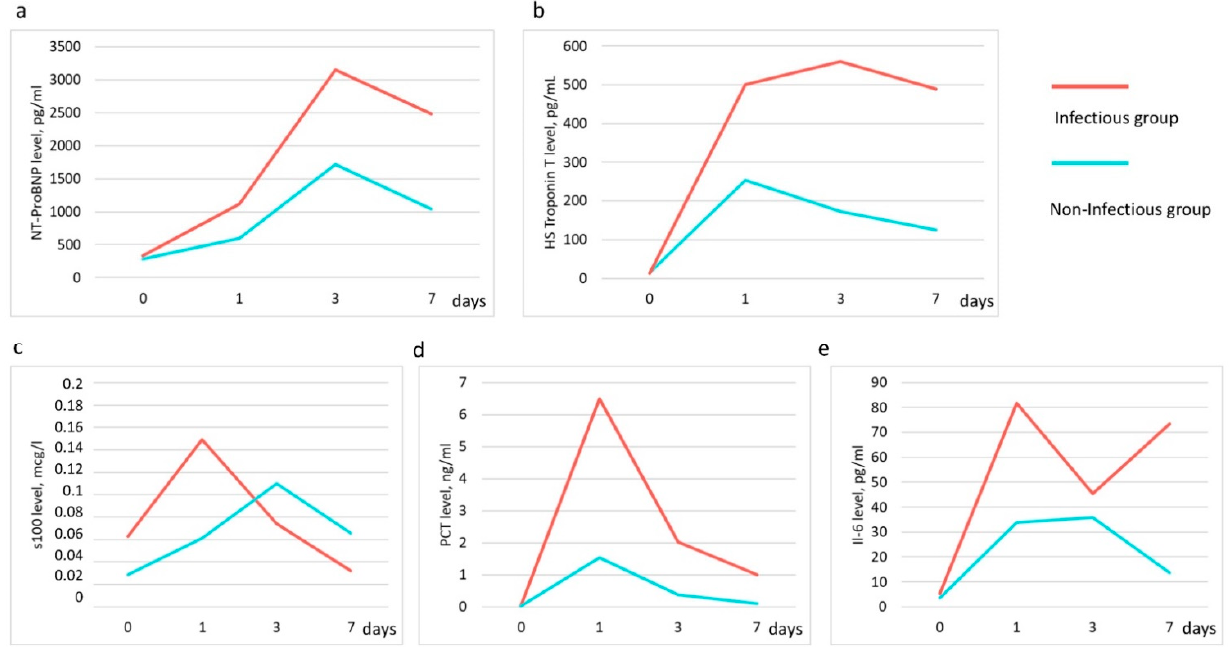
Figure 5. Dynamics of biomarker levels in patients’ groups: ( a )—NT-ProBNP, ( b )—high-sensetive Troponin T, ( c )—protein S100, ( d )-procalcitonin (PCT) and ( e )—interleukin-6 (IL6).